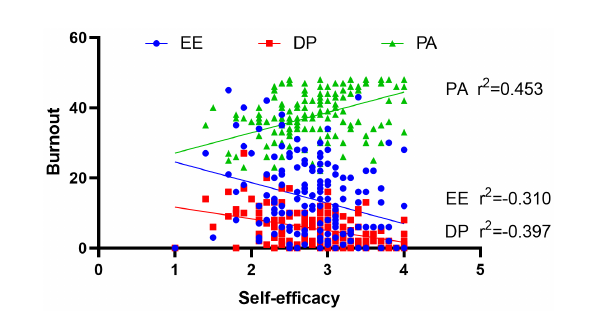
FIGURE 3 Pearson correlation between self-efficacy and burnout.